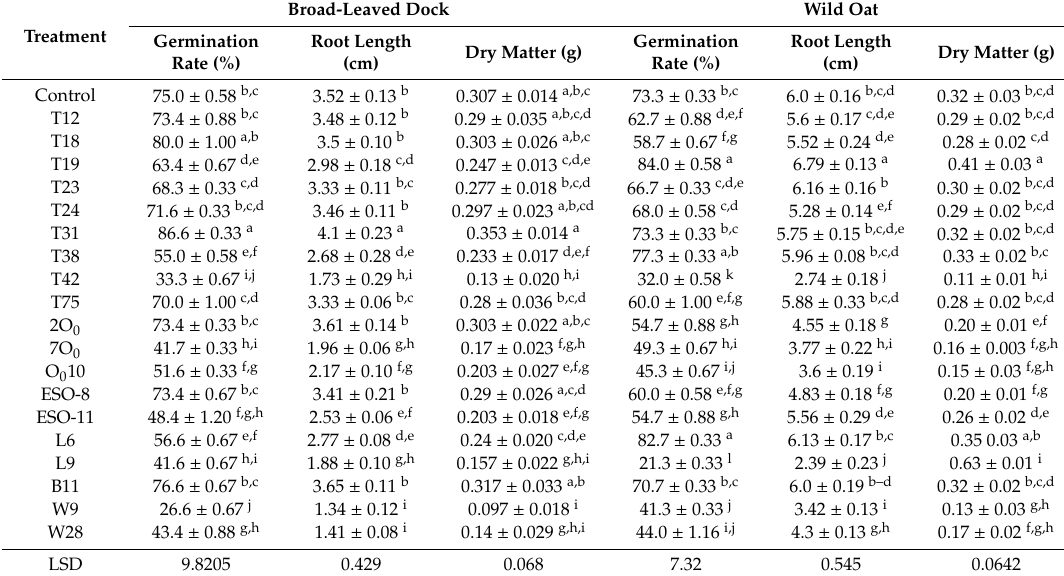
Table 3. The e ff ect of presumed allelopathic bacteria on the germination and seedling growth of broad-leaved dock and wild oat in agar bioassay. Values sharing the same letter(s) in a column do not di ff er significantly from each other at p < 0.05. Values in a column indicate mean ± standard error.